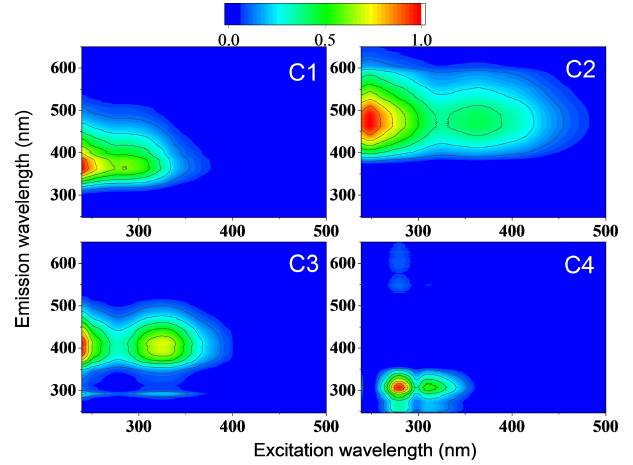
Figure 3. The four components were identified by the PARAFAC model analysis of the excitation–emission spectra from all filter ex- tracts collected in summer and winter.